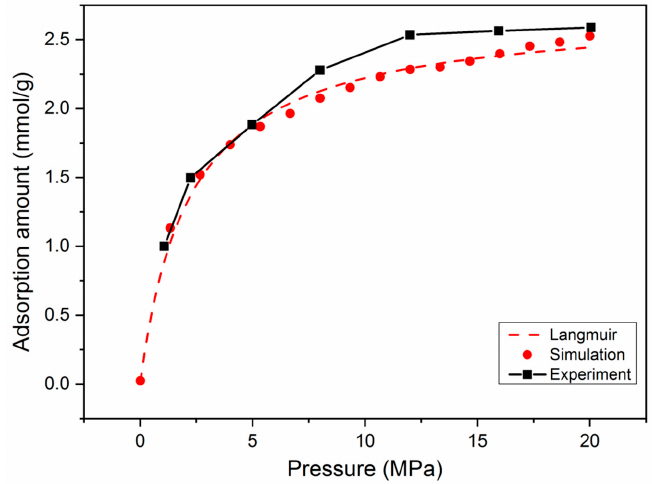
Figure 2. Comparison between simulation results, experimental data, and theoretical Langmuir fitting.